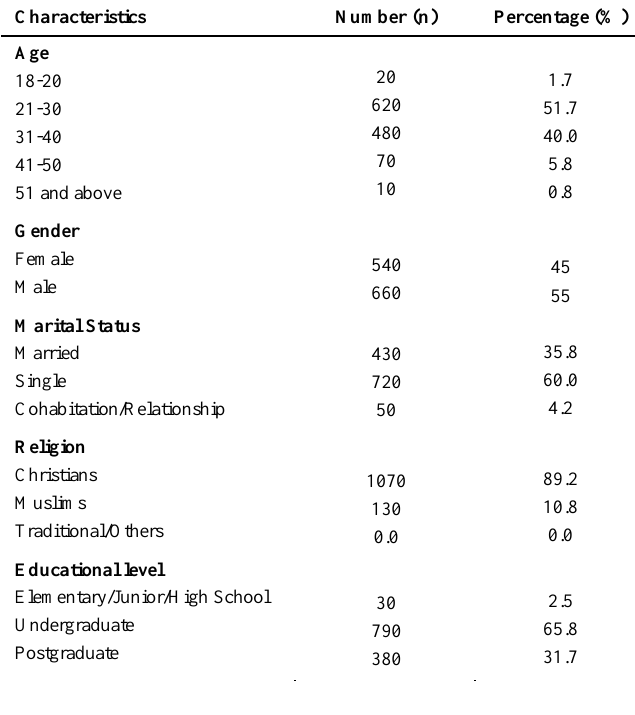
Table 1. Demographic characteristics of